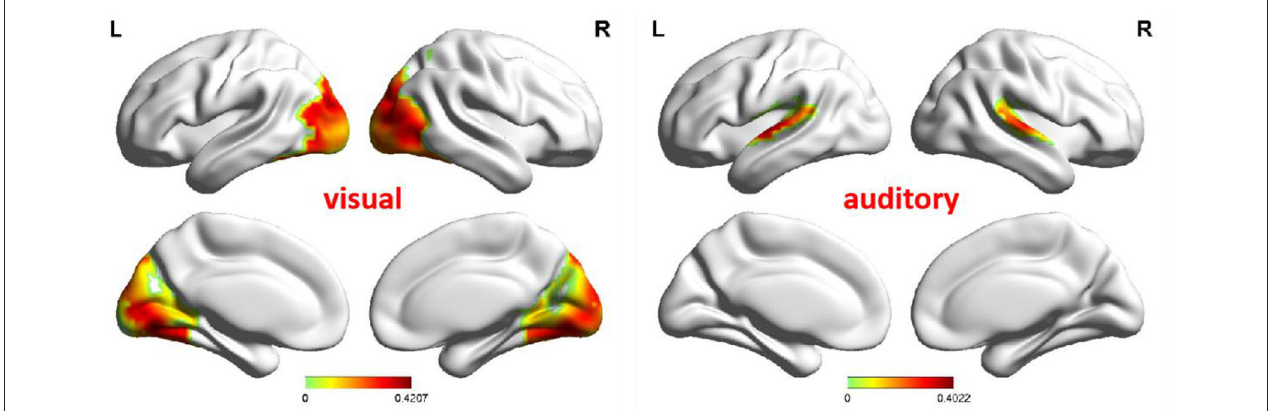
FIGURE 7 | The arousal condition of visual and auditory brain regions during Psycho clip watching.